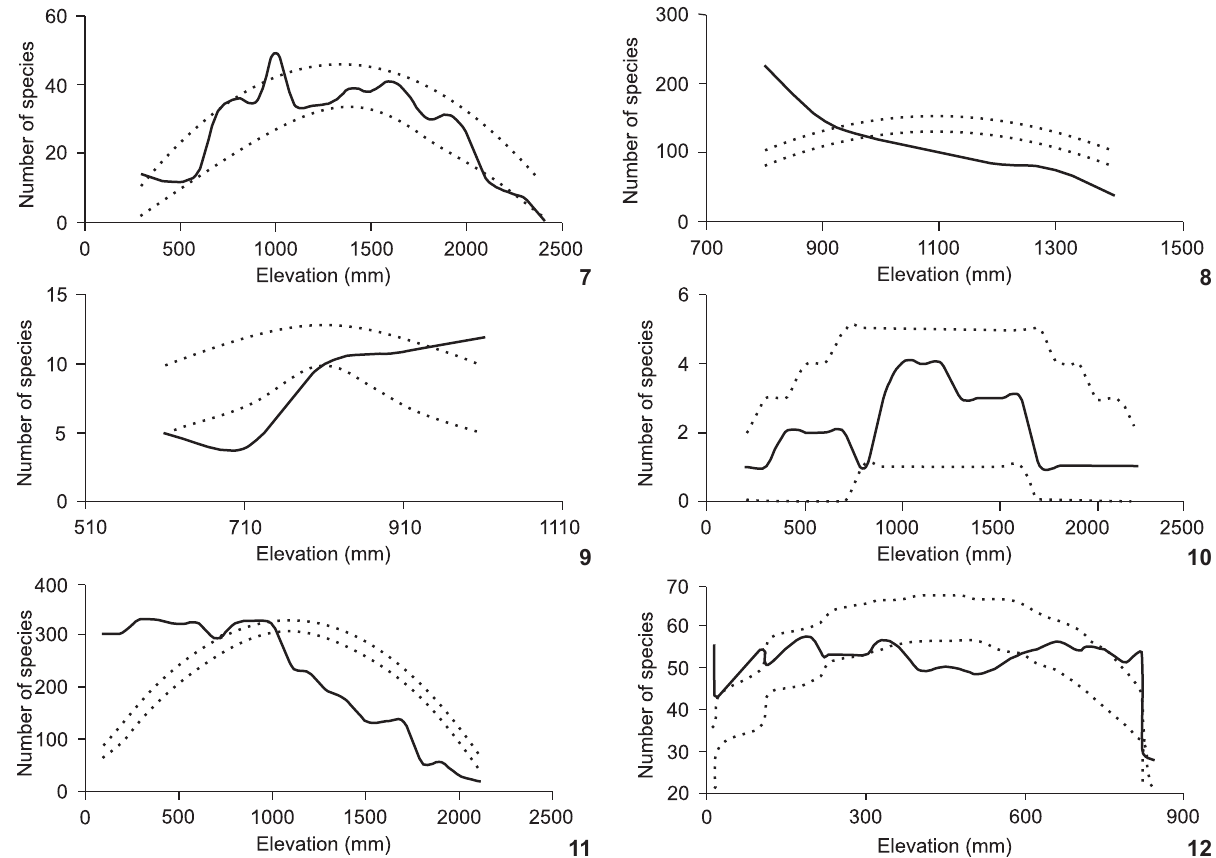
Figures 7-12. Empirical (solid lines) and the 95% CI of the predicted species richness based on 50,000 Monte Carlo simulations sampled without replacement of the six gradients we analysed from: (7) H OLT (1928); (8) M ELO -J ÚNIOR et al. (2001); (9) F ÁVARO et al. (2006); (10) R AJÃO & C ERQUEIRA (2006); (11) M ALLET -R ODRIGUES et al. (2010); (12) present